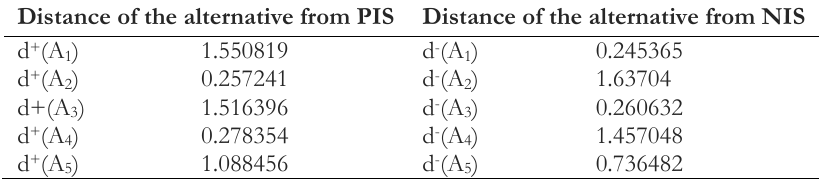
Table 6. Distances of alternatives from PIS and NIS.